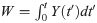
Relative evolution since 1980 of the world real GDP Y, economic potential W=∫0tY(t′)dt′ (Eq 19), primary energy consumption E, λ=E/W (Eq 18) and the energy intensity of production i≕E/Y=1/ε.